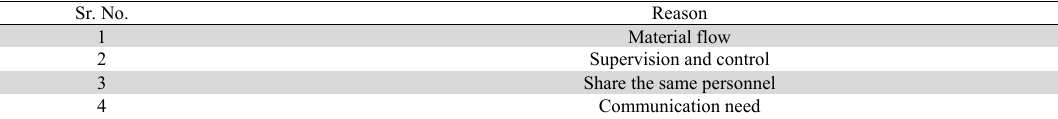
Reasons for closeness